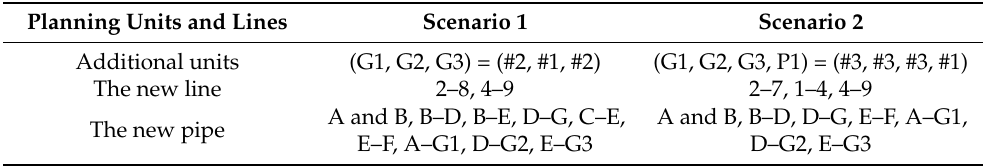
Table 1. Comparisons of planning results.